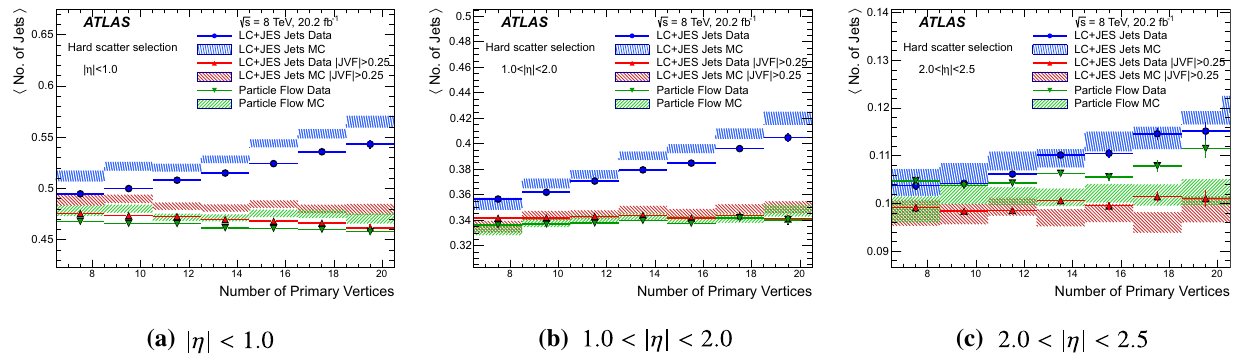
Fig. 31 The average number of jets per event, for jets with p T > 20GeV, as a function of the number of primary vertices in the Z → μμ samples. The distributions are shown in three different | η | regions for particleflowjets,calorimeterjetsandcalorimeterjetswithanadditional